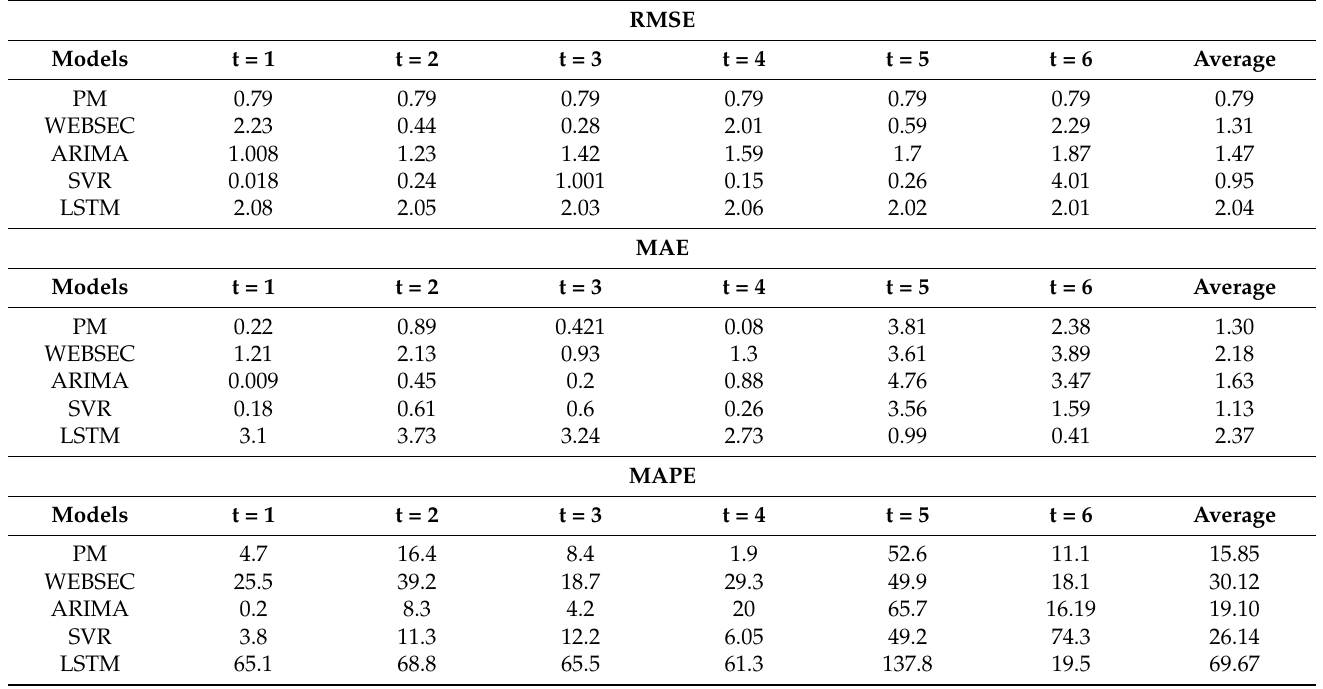
Table 9. Performance results of different univariate WSP models for Arizona Hills region.